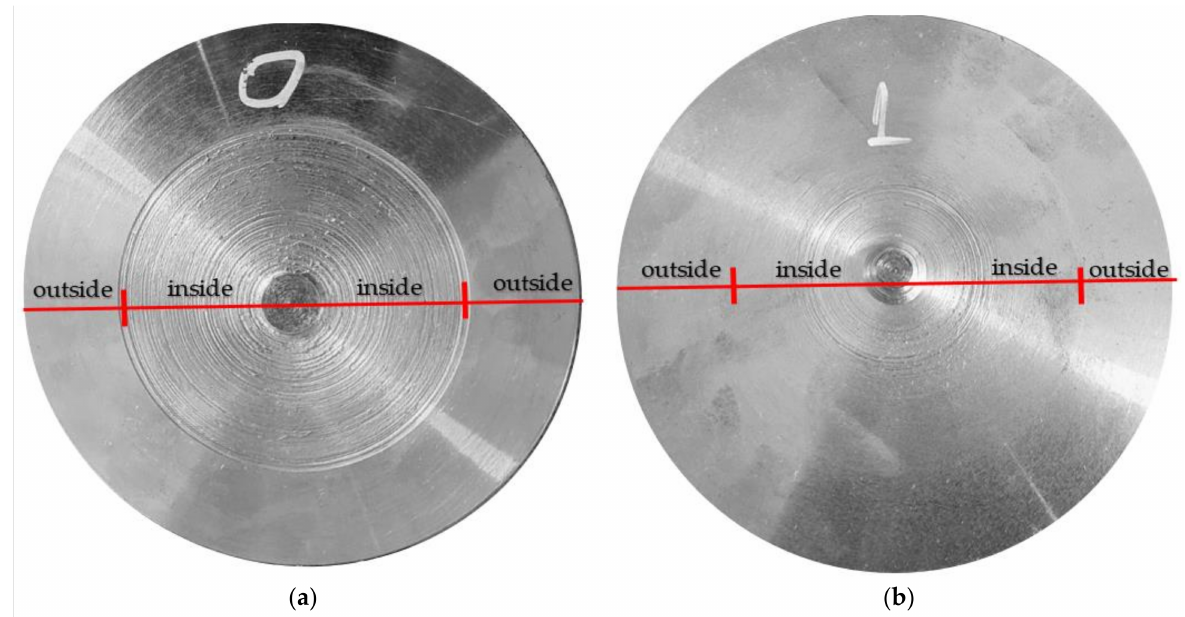
Figure 9. Images with surface roughness obtained by machining: ( a ) in the case of machining with a T01 cutting tool; ( b ) in the case of machining with a T02 cutting